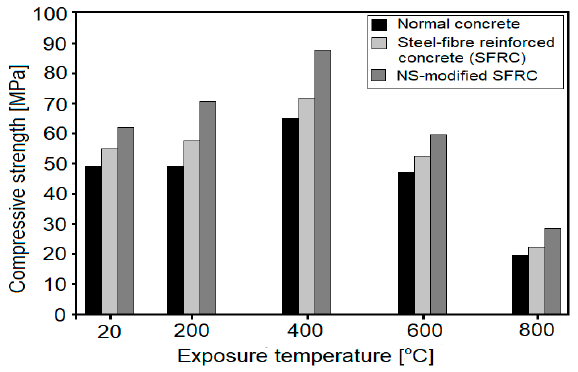
Figure 6. Compressive strength of normal concrete, SFRC and NS-modified SFRC, as a function of temperature. Redrawn from [51].